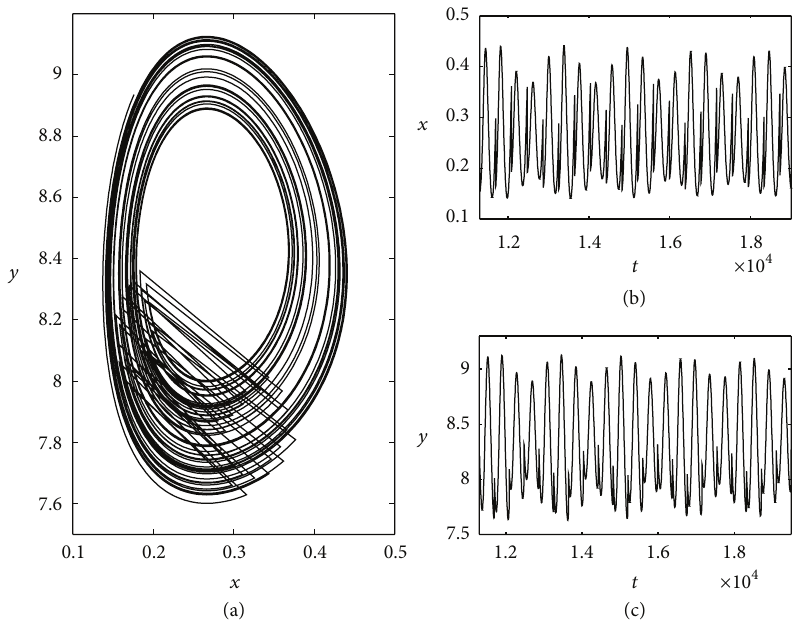
Figure 5: A typical quasiperiodic solution of model (24) over 𝑡 ∈ [11300, 19000] . (a) Phase portrait of 𝑥 and 𝑦 with 𝑡 ; (b) time series of 𝑥 , and (c) time series of 𝑦 . The other parameters are identical to those in Figure 4 and 𝑇 = 7.8 .